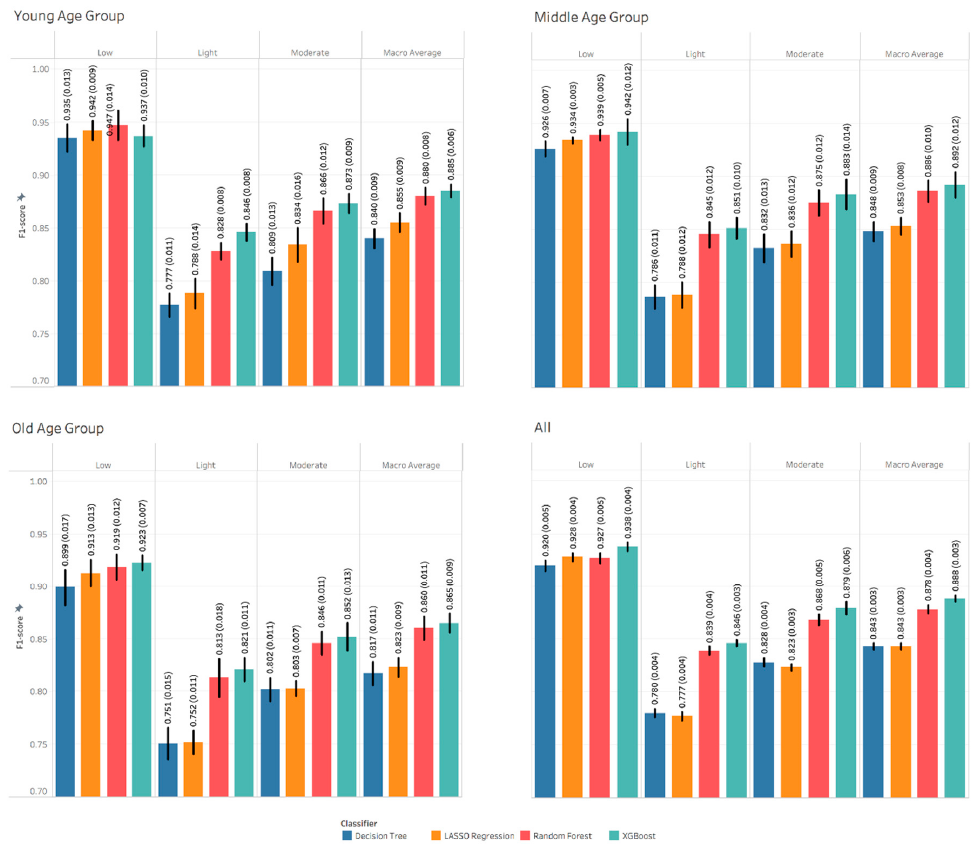
Figure 3. Performance metrics of recognizing physical activity intensity. Each value is the mean and standard deviation of the 5-fold nested cross validation.